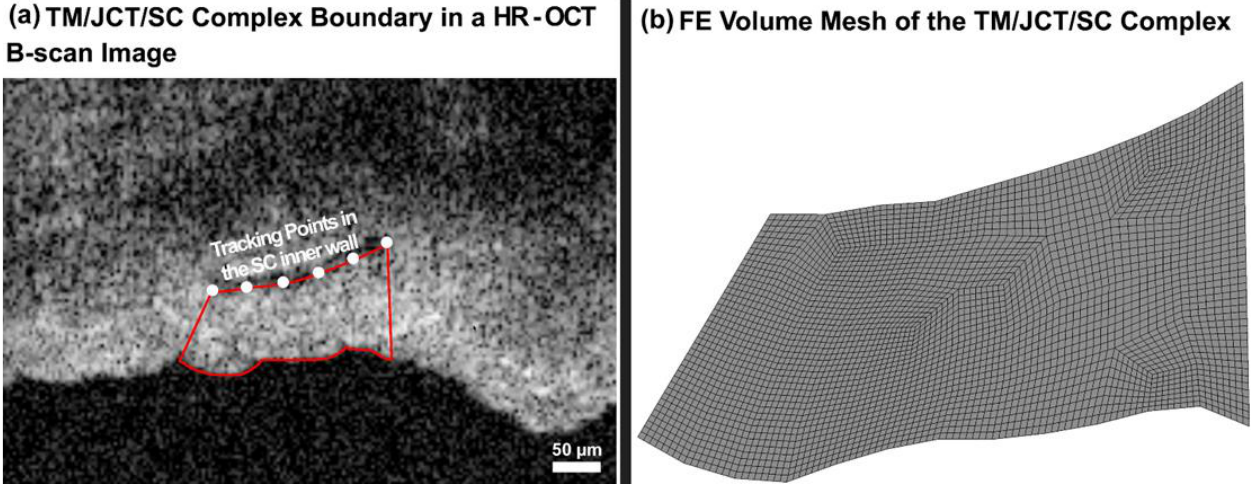
Figure 7. The ( a ) TM/JCT/SC complex boundary in the HR-OCT B-scan Image. ( b ) Finite element mesh of the TM/JCT/SC complex. The dynamic motion of defined points in the SC inner wall were tracked throughout the pressure elevation.